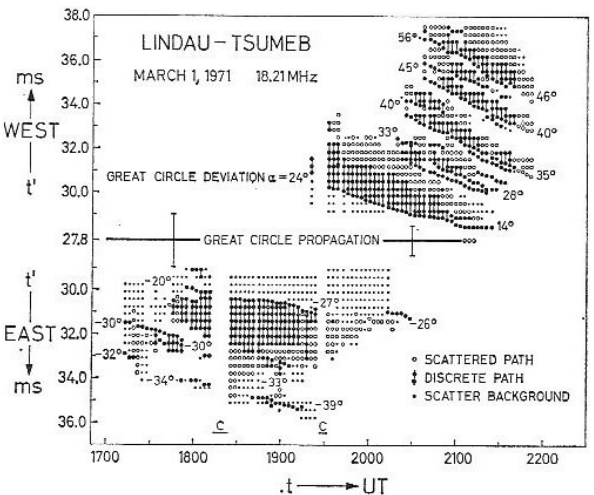
Figure 6. Plot of electron density, vertical drift and range-time occurrence of Spread F. Although taken from Woodman and La Hoz (1976), it illustrates the conclusions of Farley et al. (1970): None of the current theories existing then could explain the simultaneous presence of irregularities at positive and negative electron density gradients or positive and negative eastward electric fields.